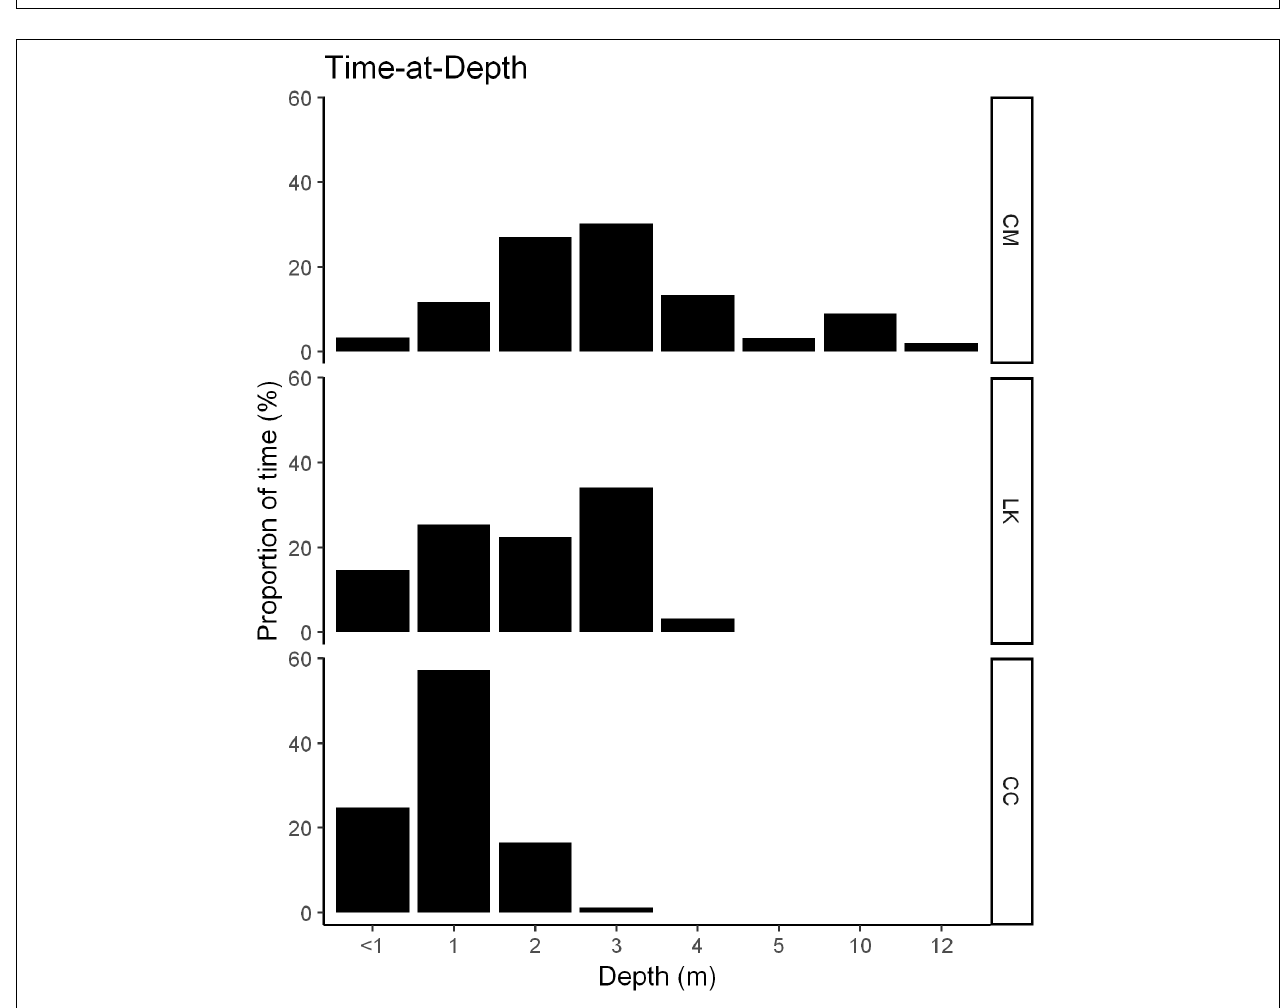
of CM (17.5 ± 12.5 s) was significantly lower than that of LK (21.6 ± 13.0 s) (LMEM fit by REML; t -value = 4.59459, df = 10, p = < 0.0010) and that of CC (22.5 ± 22.8 s)